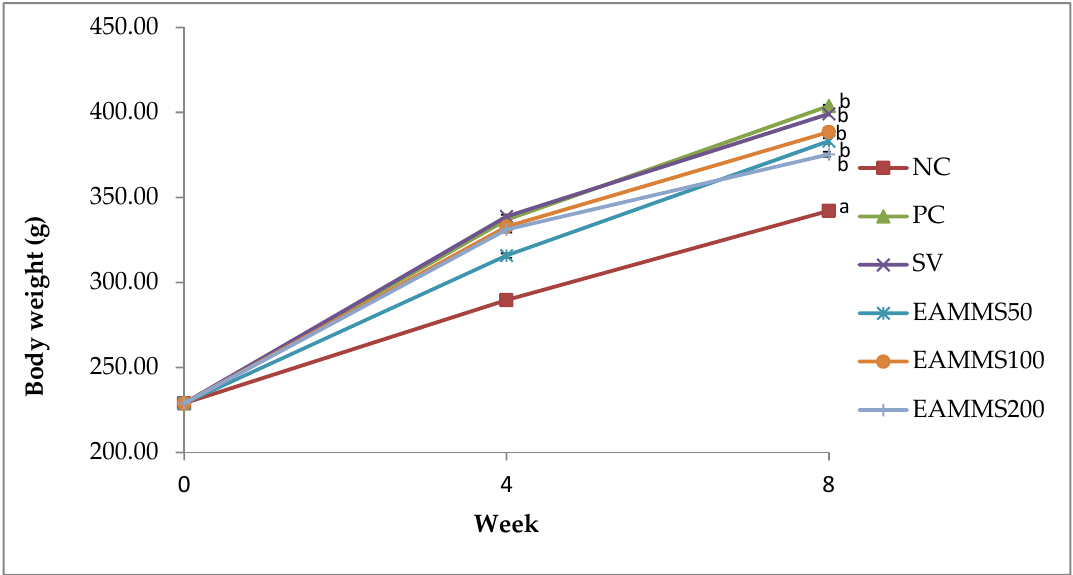
Figure 1. Effects of ethyl acetate extract of Mikania micrantha stems (EAMMS) on body weight in hypercholesterolemia rats. Values are expressed as mean ± SEM ( n = 6). Means with different superscripts (a or b) indicate statistically different at p < 0.05 using Tukey’s multiple comparison test. NC—Normal control; PC—Positive control with high cholesterol diet (1%); SV—High cholesterol diet (1%) with simvastatin (10 mg/kg body weight); EAMMS50—High cholesterol diet (1%) with ethyl acetate Mikania micrantha stem extract (50 mg/kg body weight); EAMMS100—High cholesterol diet (1%) with ethyl acetate Mikania micrantha stem extract (100 mg / kg body weight); EAMMS200—High cholesterol diet (1%) with ethyl acetate Mikania micrantha stem extract (200 mg / kg body